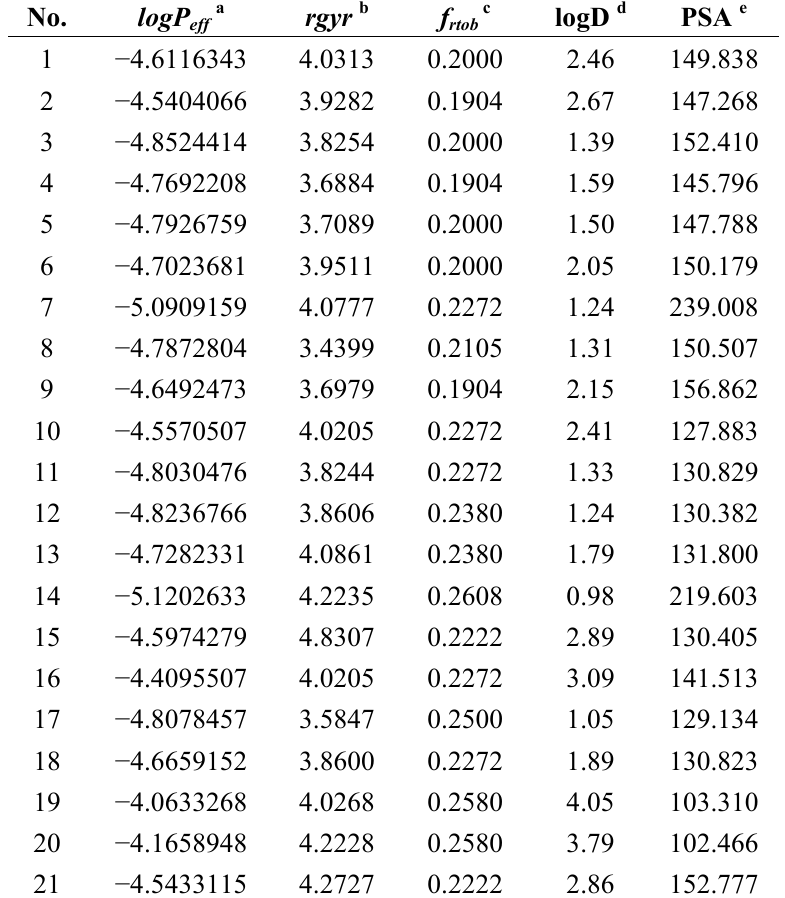
. for Mtb cell eff